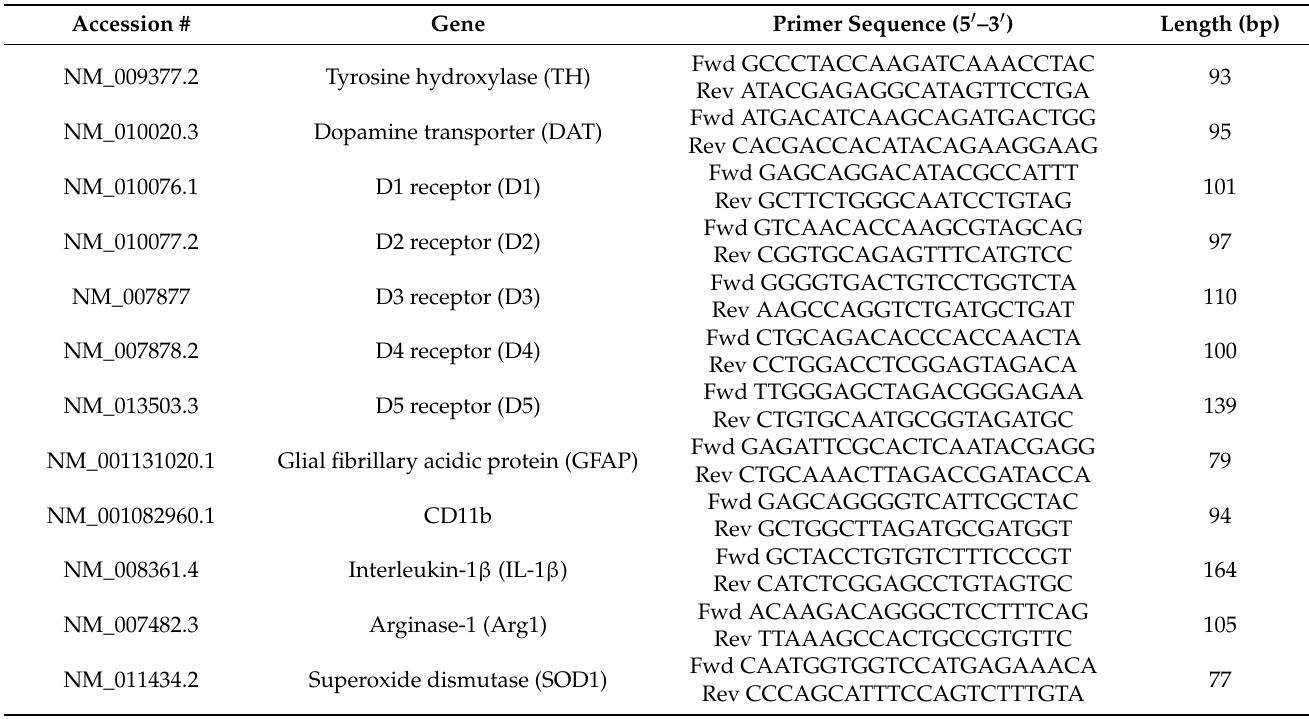
Table 1. List of primer sets used in real-time qPCR analyses. Gene Primer Sequence (5 (cid:48) –3 (cid:48)